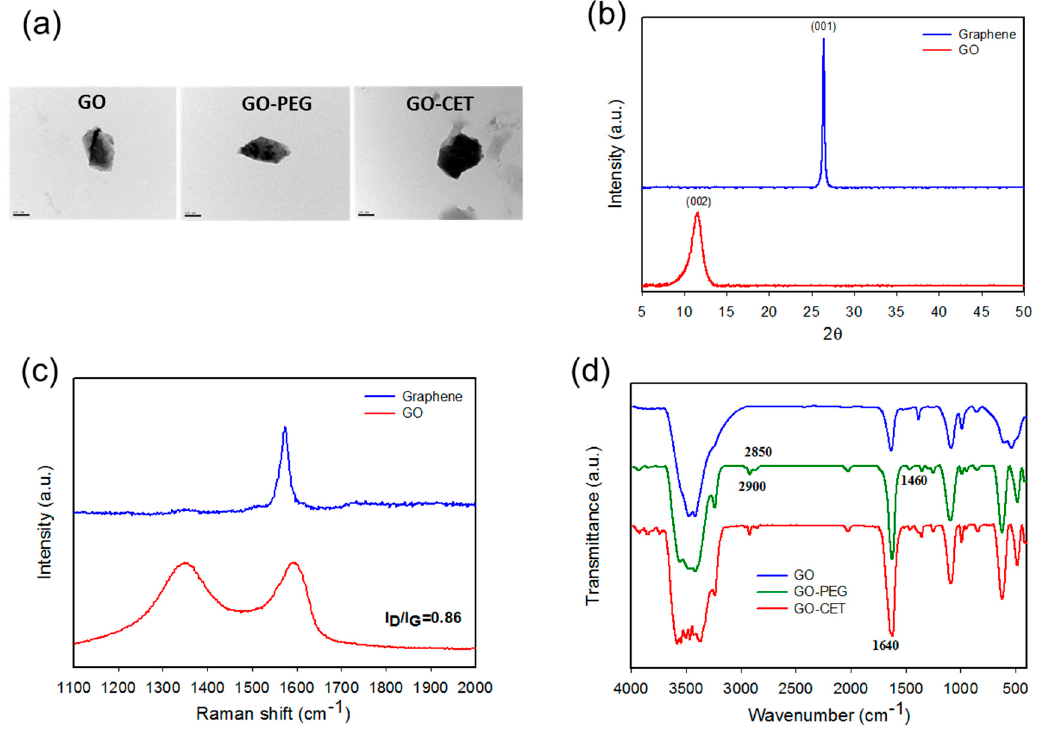
Figure 2. Characterization of nanocarriers by transmission electron microscopy (TEM) (bar = 100 nm) ( a ), X-ray diffraction (XRD) ( b ), Raman spectroscopy ( c ), and Fourier transform infrared (FTIR) spectroscopy ( d ).